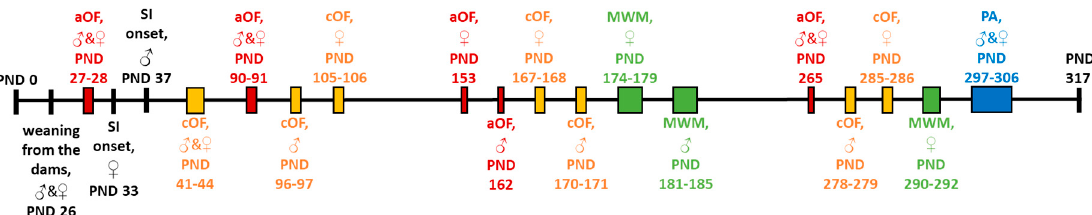
Figure 1. Age of behavioral assessment. Postnatal day 0 (PND0)–the day of birth; PND317–the day at which the animals were sacrificed; SI–social isolation; aOF–automated open field test; cOF–classic open field test; MWM–Morris water maze; PA–passive avoidance paradigm; ♀ –female rats; ♂ –male